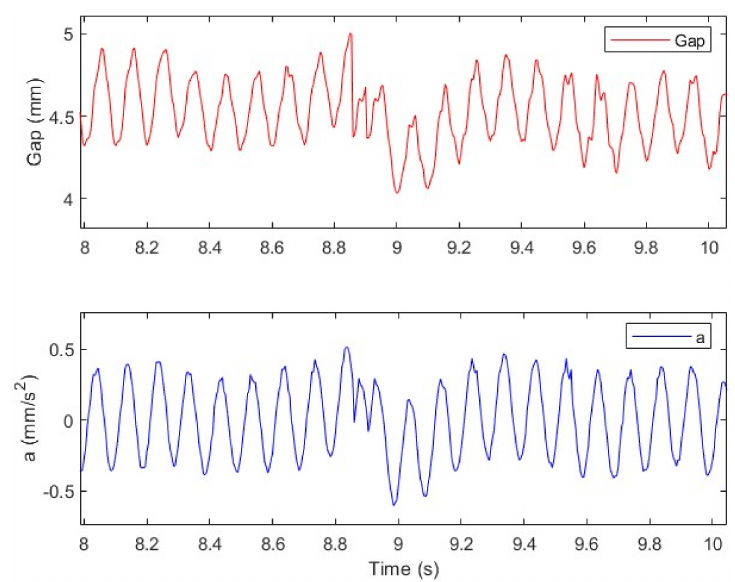
Figure 13. The gap and acceleration of the track when the self-excited vibration occurs. The track was first fixed with rigid constraints to test whether the control algorithm could achieve suspension on a rigid track. The control parameters were: a 1 = 5, 000, 000, a 2 = 400, 000, a 3 = 8200, and a 4 = 120, which satisfied the requirements of Equation (45). The poles of the system were s 1 = − 16.3862 + 62. 1486 i, s 2 = − 16.3862 − 62. 1486i, s 3 = − 69.9154, and s 4 = − 17.3119. Figure 14 shows the Bode diagram of the system. As expected, the gain of the system in the low frequency band was about − 134 dB, which satisfied the requirement of low gain. The phase shift of the system in the low frequency band was very small, which further proved the good stability of the system. Figure 15 shows the effect of the control scheme proposed in this paper. The actual and expected magnetic flux, the suspension gap, and the vertical track velocity are plotted, respectively.